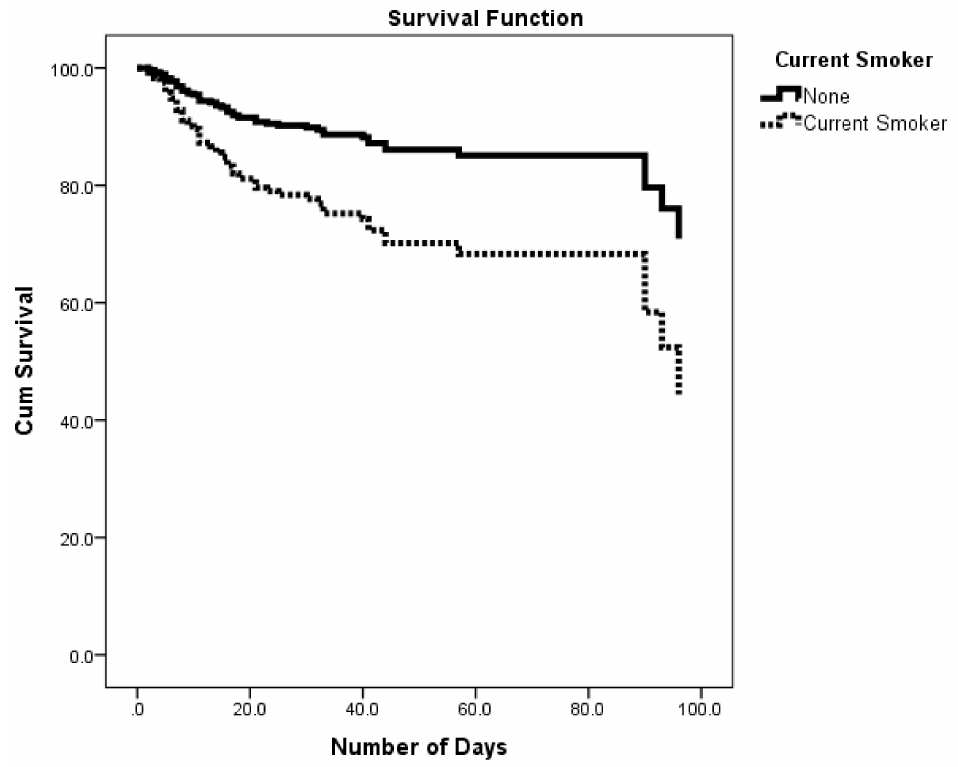
Figure 2. Survival rates for in-hospital stroke patients by current smoking status.